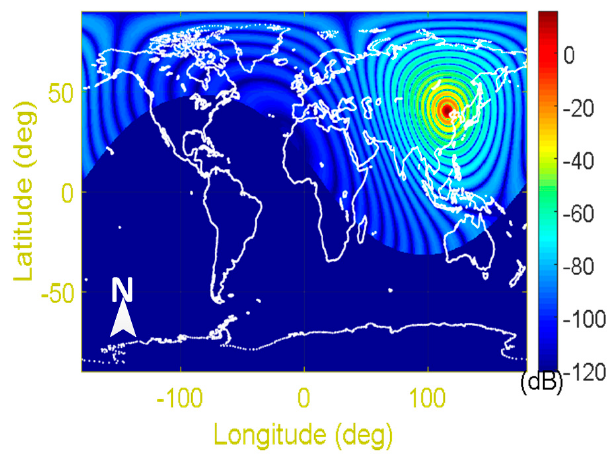
Figure A5. GEO SAR SINR based on the Beidou-2 IGSO navigation satellite data.